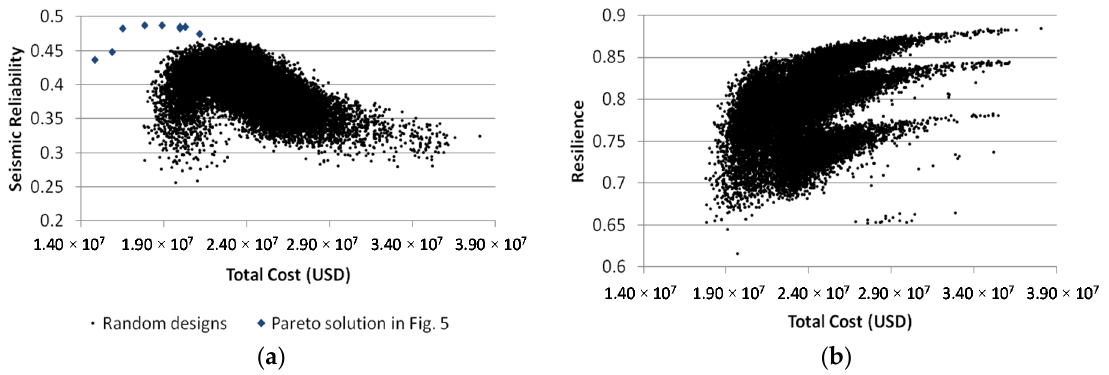
Figure 9. ( a ) Seismic reliability of randomly generated solutions ( black dot ) and Pareto solutions shown in Figure 7 ( blue diamond ) and ( b ) resilience of the same random designs.